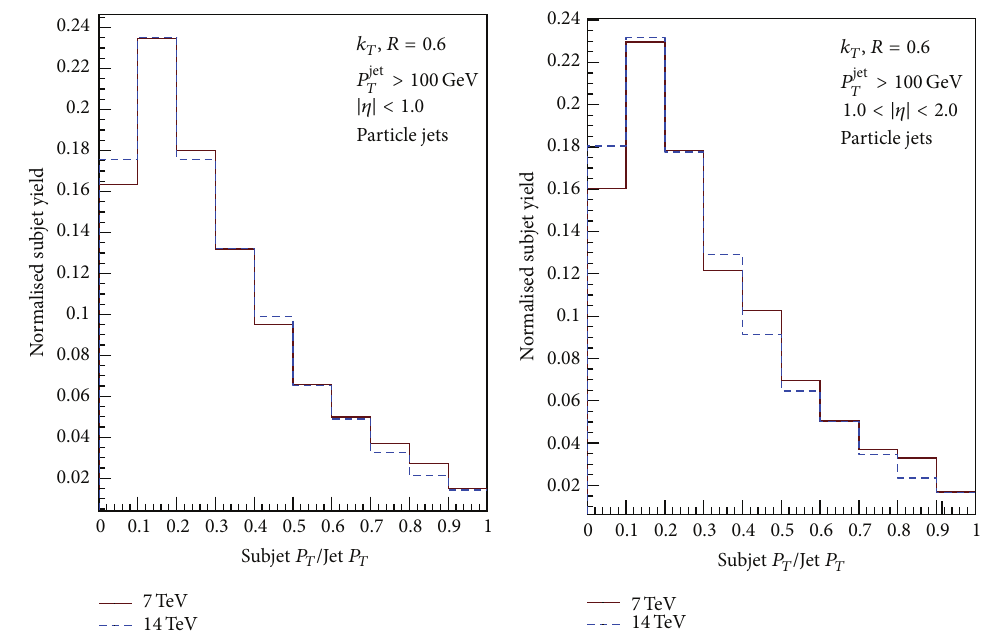
Figure 4: Distributions of the subjet 𝑃 𝑇 fraction in particle jets having 𝑃 jet 𝑇 > 100 GeV from 𝑘 𝑇 algorithm at √𝑠 = 7 TeV compared to √𝑠 = 14 TeV in the pseudorapidity bins of |𝜂| < 1 and 1 ≤ |𝜂| < 2 .